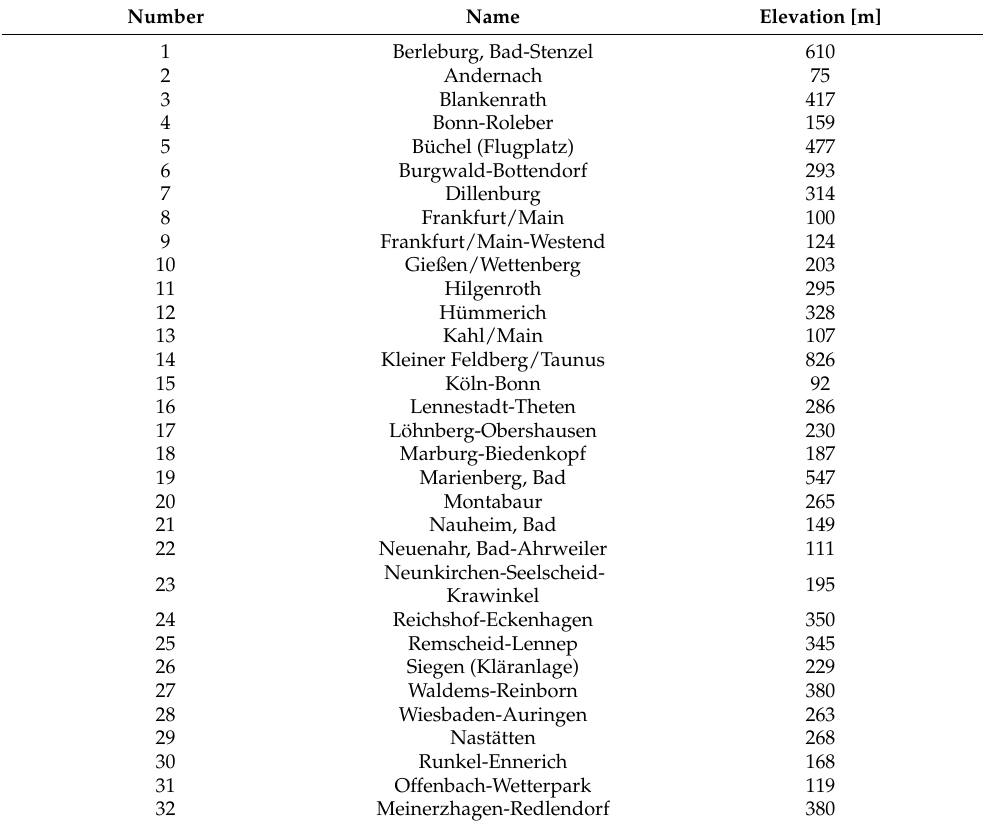
Figure 1. ( left ) A map of the research domain. The CMLs are indicated by black lines and the weather stations’ locations by their number in white circles (Stations list, Table 1). The CMLs are located in a larger domain of ~40 km around the study domain. For the topographic map of the region and the research domain in it see right panel ( right , black square). Points B, S, and F represent Bonn, Siegen, and Frankfurt, respectively (Stations 15, 26, and 9 in Table 1, respectively). Table 1. A list of the weather stations and their elevation AMSL in meters.